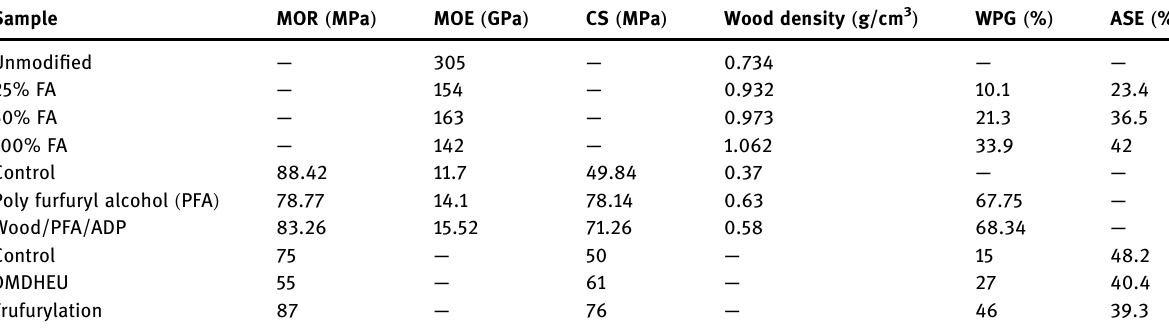
Table 2: Properties of wood treated with furfuryl alcohol ( FA ) and other modi fi ed methods